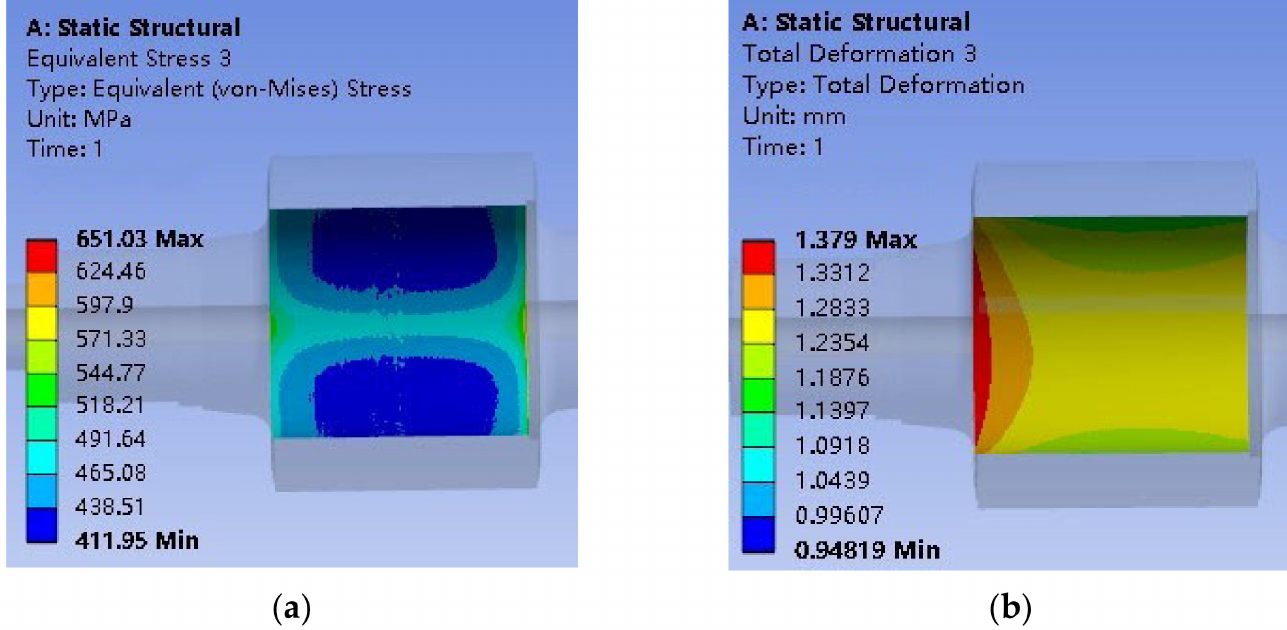
Figure 9. Simulation nephograms of roller sleeve: ( a ) equivalent stress nephogram; ( b ) total deformation